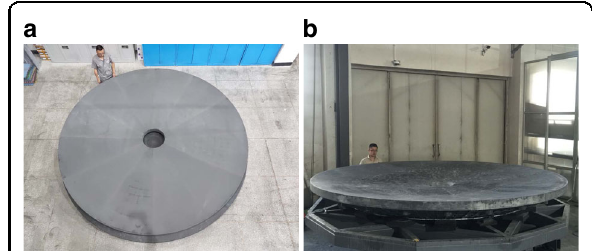
Fig. 5 ⌀ 4.03 m SiC blank after parts joining and sintering. a Green body, b mirror blank after sintering